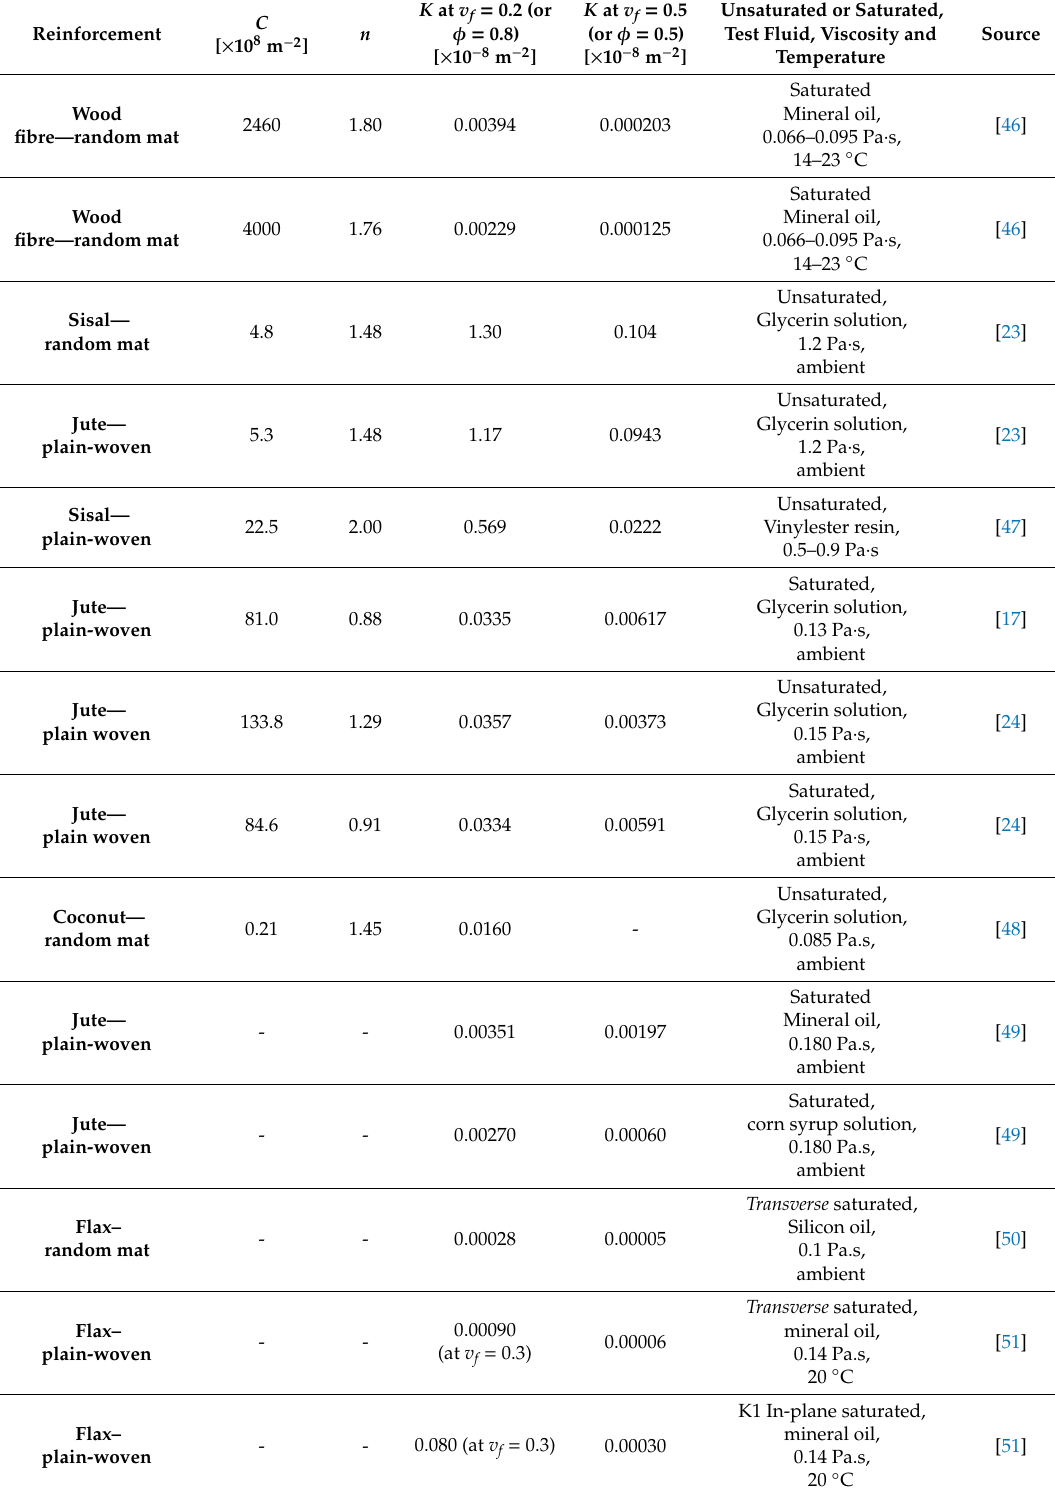
Table 2. In-plane permeability data for various plant fibre reinforcements. Carman–Kozeny constants (C and n, Equation (5)) are provided. It is specified whether data are for transverse or through-thickness